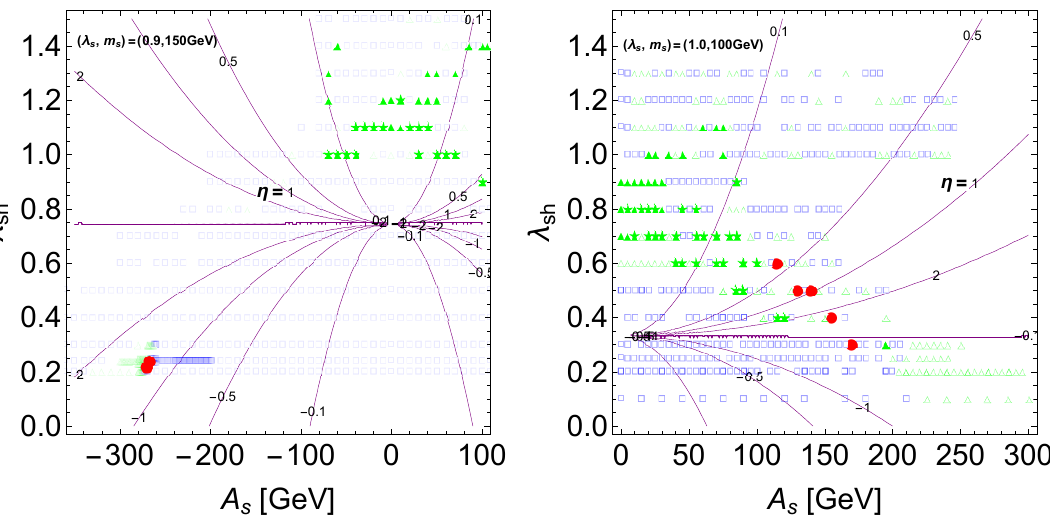
Figure 8 . Global picture of multi-step PT in the ( A s ; (cid:21) sh ) plane for ( (cid:21) s ; m s [GeV]) = (0 : 9 ; 150) (left panel) and (1 : 0 ; 100) (right panel). PT of three-step (red, circle), two-step (green, triangle for the second-(cid:12)rst order PT or star for the (cid:12)rst-(cid:12)rst order PT) and one-step (blue, square) are plotted. Filled plots satisfy the condition of SFOEWPT in eq. (1.1). In (cid:17) < 0 region, the three-step PT can happen only in a very narrow space, consistent with (cid:12)gure